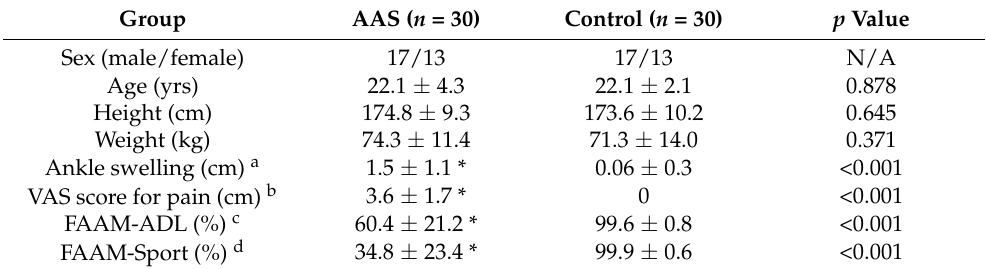
Table 1. Participant demographics of the acute ankle sprain (AAS) and control group (mean ±